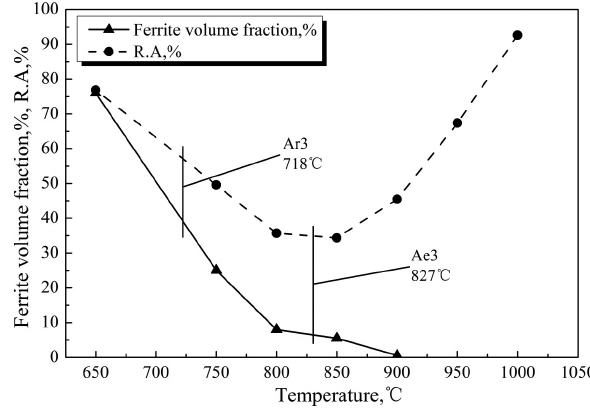
Fig. 4: Ferrite volume fraction and R.A. as a function of temperature in Ti-bearing